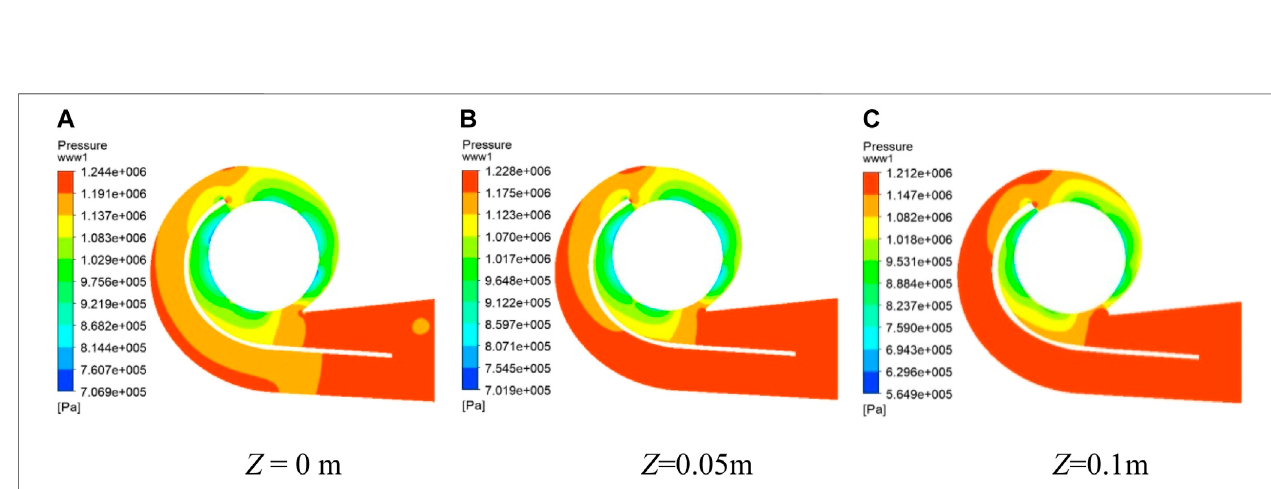
FIGURE 7 | Q = 4.0 m 3 /s spiral shell cross-sectional pressure diagram. Z in represents different cross-sectional heights.